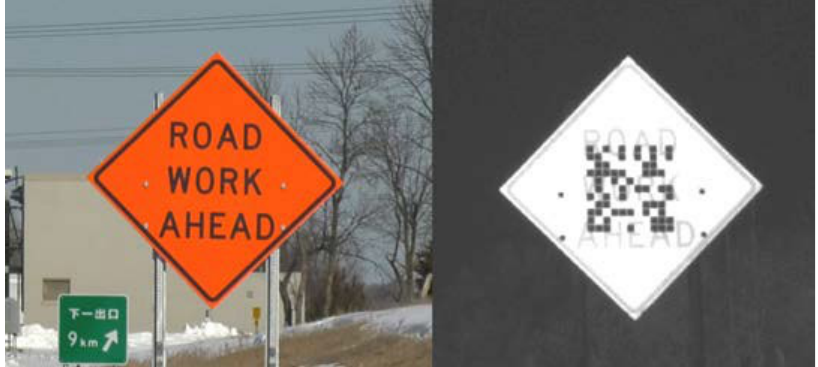
Figure 3. Example of visible and near-IR view of QR code (Source: [14]).